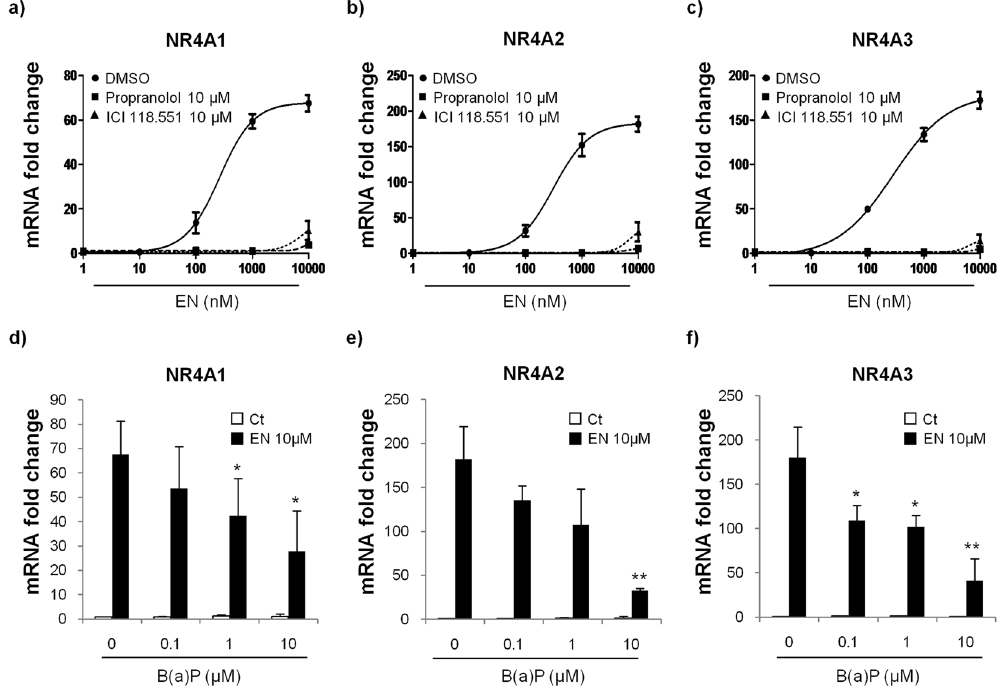
Figure 1. B(a)P decreased β 2ADR-mediated induction of NR4As expression triggered by epinephrine (EN). ( a , b , c ) HMEC-1 cells were either untreated or exposed to indicated concentrations of EN for 1 h, in the presence or not of 10 µ M propranolol (nonselective β -blocker) or 10 µ M ICI 118.551 (selective β 2-bloker). mRNA expressions of β 2ADR-target genes, NR4A1 ( a ), NR4A2 ( b ) and NR4A3 ( c ) were next determined by RT-qPCR. ( d , e , f ) HMEC-1 cells were exposed to indicated concentrations of B(a)P or vehicule (DMSO) for 24 h before being co-exposed, or not, to 10 µ M EN for 1 h. mRNA expressions of β 2ADR-target genes, NR4A1 ( d ), NR4A2 ( e ) and NR4A3 ( f ) were next determined by RT-qPCR. Data are expressed relatively to mRNA levels found in untreated cells, arbitrarily set to 1 unit, and are the means ± S.D of at least three independent assays. * p < 0.05; ** p < 0.01 when compared to B(a)P-untreated